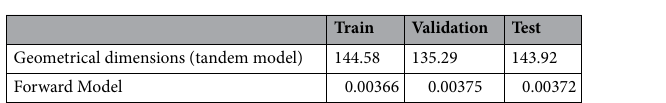
Table 1. Mean squared error (MSE) losses for the tandem and forward